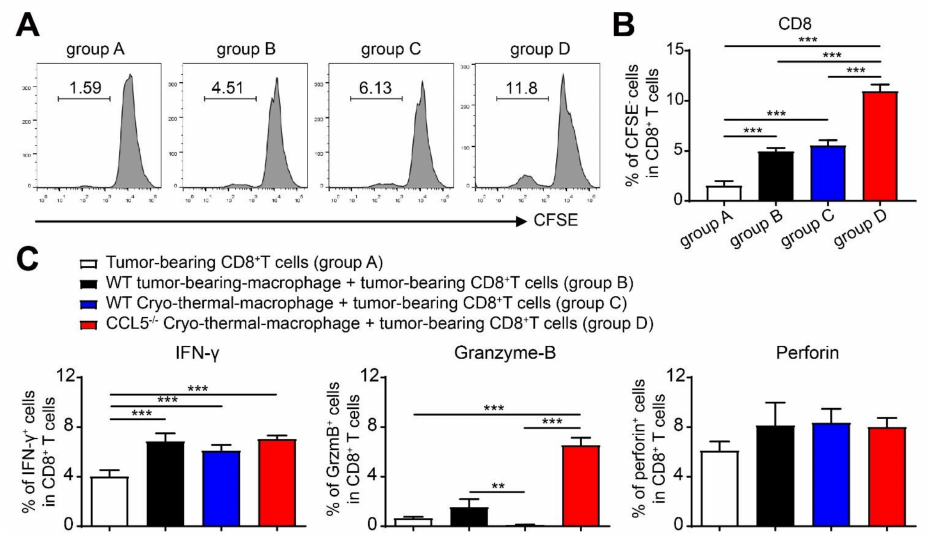
Figure 8. CCL5-deficiency-enhanced M1 polarization was required for the proliferation and cyto- toxicity of CD8 + T cells. Splenic CD8 + T cells from WT control mice were pre-treated with CFSE and then cultured with macrophages from WT control mice, treated WT, or CCL5 − / − mice in vitro for 24 h. The gating strategy ( A ), percentage of CFSE − CD8 + T cells ( B ), and the expression level of IFN- γ , Granzyme B and perforin ( C ) were tested with FACS. n = 4; mean ± SD. The data of FACS were analyzed with FlowJo 7. Data were processed using one-way ANOVA in GraphPad Prism 9. ** p < 0.01; *** p <